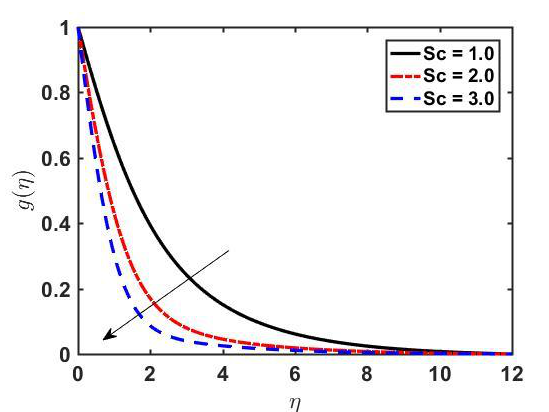
Figure 8. Profile of 𝑔(𝜂) versus 𝜂 for various values of 𝑆𝑐 by fixing 𝜆 = 0.3, 𝑀 = 0.5, 𝑃𝑟 = 0.5, 𝐿𝑒 = 3.0, 𝑁𝑏𝑡 = 2.0, and 𝑁𝑐 = 0.5.